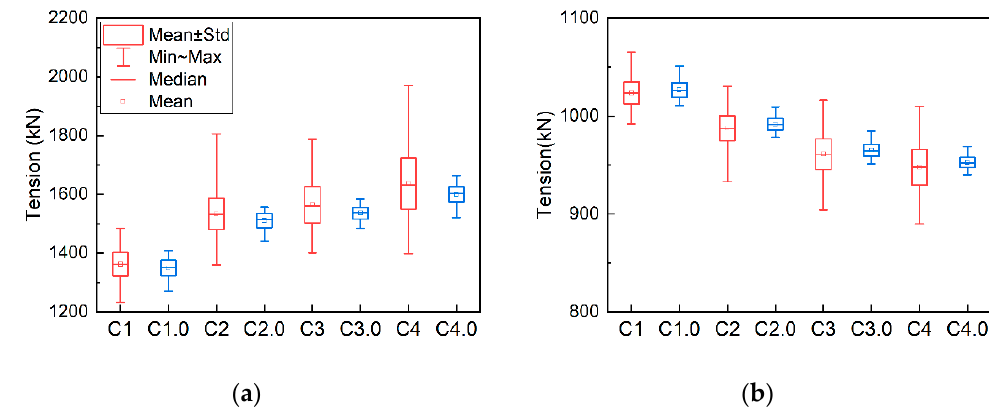
Figure 15. Line tensions under different wind–wave sea scenarios. ( a ) Line 1; ( b ) Line 2.